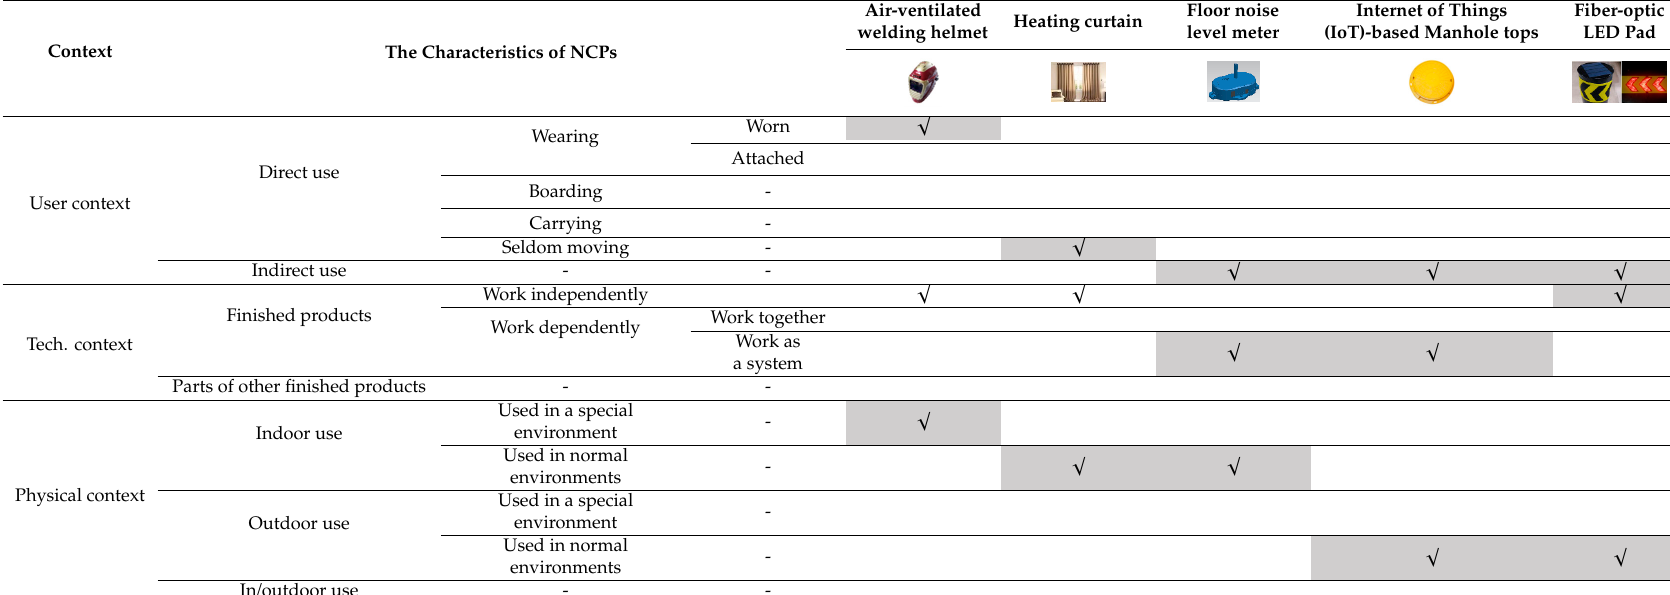
Table 2. Sample Analyses of the Real-use Environment of new technological convergence products (NCPs).